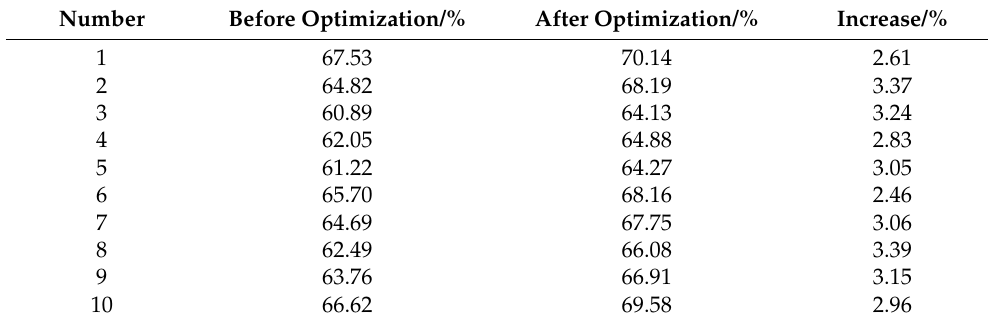
Table 12. Feature optimization effects achieved by the RF classifier on ten material verification